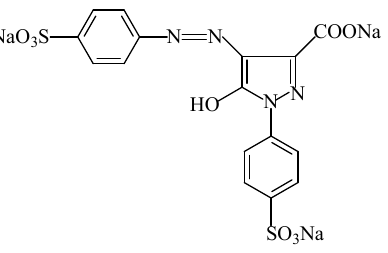
Figure 15. Structural formula of tartrazine (E102).